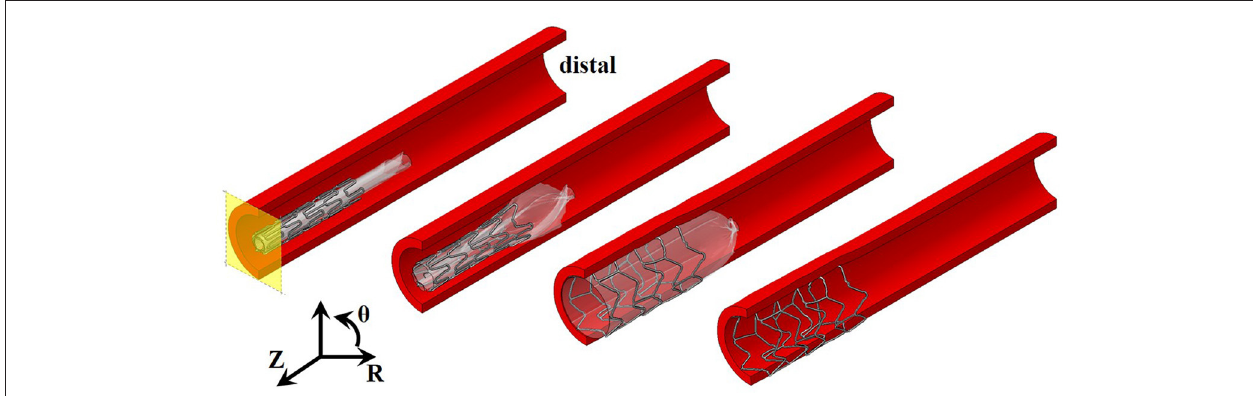
FIGURE 2 | Stages of stent expansion for pressurization of a trifolded balloon. Pressure applied to the internal surface of the balloon (transparent white) results in expansion of the distal end of the stent first, and then the central region before full deployment. Axial plane of symmetry shown in yellow and cylindrical coordinate system used, where Z represents axial direction, θ represents circumferential direction, and R represents radial